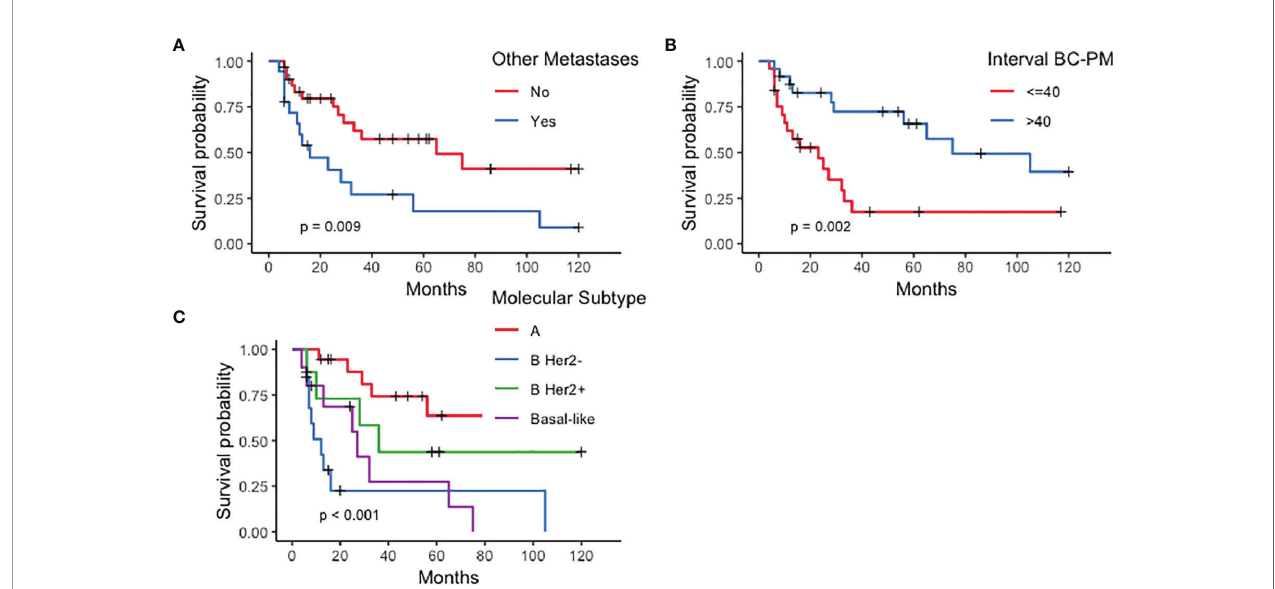
FIGURE 2 | Kaplan – Meier curves plotted for prognostic factors signi fi cantly in fl uencing survival in patients with peritoneal metastases from breast cancer (PMBC). (A) Other metastases; (B) Interval between breast cancer (BC) and peritoneal metastases (PM) diagnosis; (C) molecular